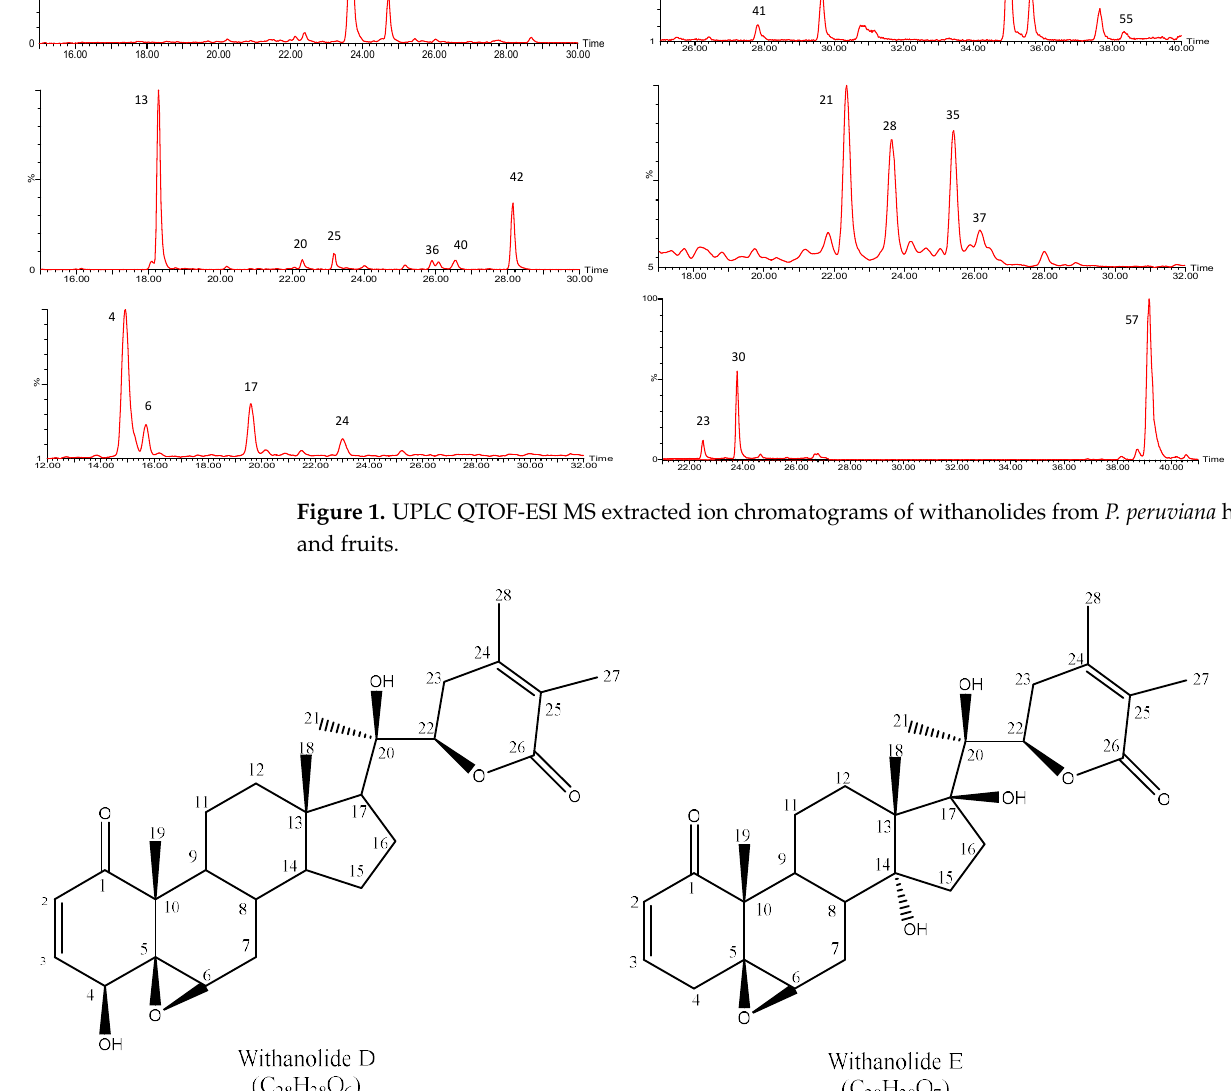
Figure 2. Withanolide D and E structures. Table 1 summarizes these compounds’ molecular ion [M-H] − and the common frag- mentation pattern due to the loss of their lactone moieties [M-H-Lac] − and the loss of water molecules [M-H-H 2 O] − and [M-H-2H 2 O] − , as well as fragments derived from the loss of their lactone moiety and water altogether [M-H-Lac-H 2 O] − and [M-H-Lac-2H 2 O] − .